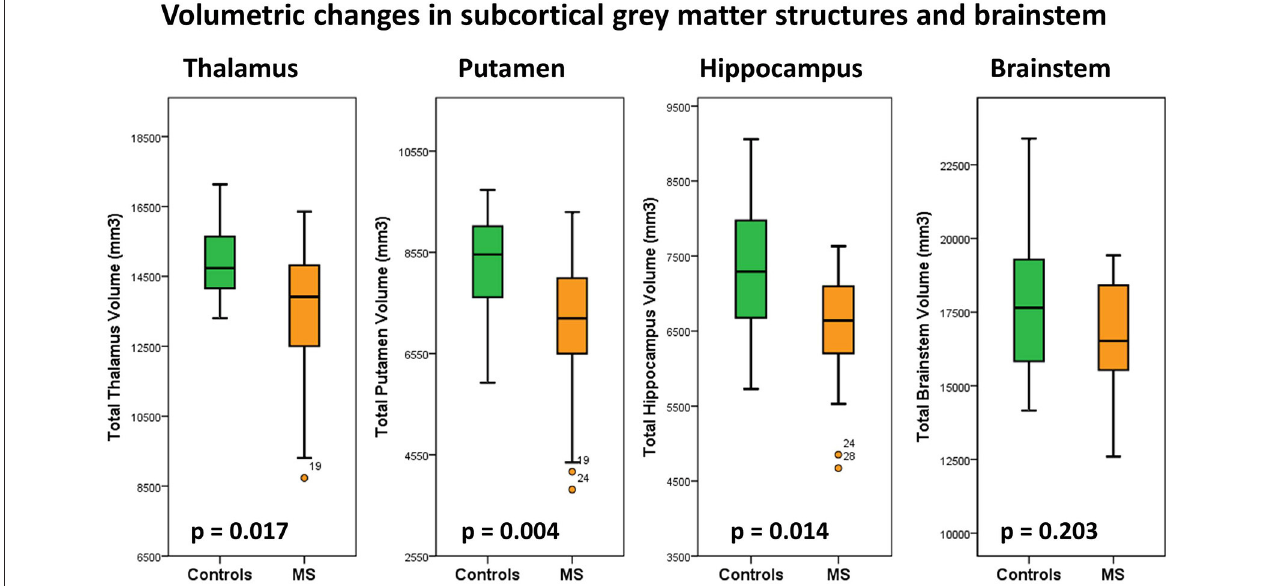
FIGURE 6 | Total thalamus, putamen, hippocampus and brain stem volumes in healthy controls (green) and multiple sclerosis patients with gaze-evoked nystagmus (orange). P -values are corrected for age, gender and total intracranial volume. A statistical threshold of p < 0.0125 is considered significant following Bonferroni corrections for multiple